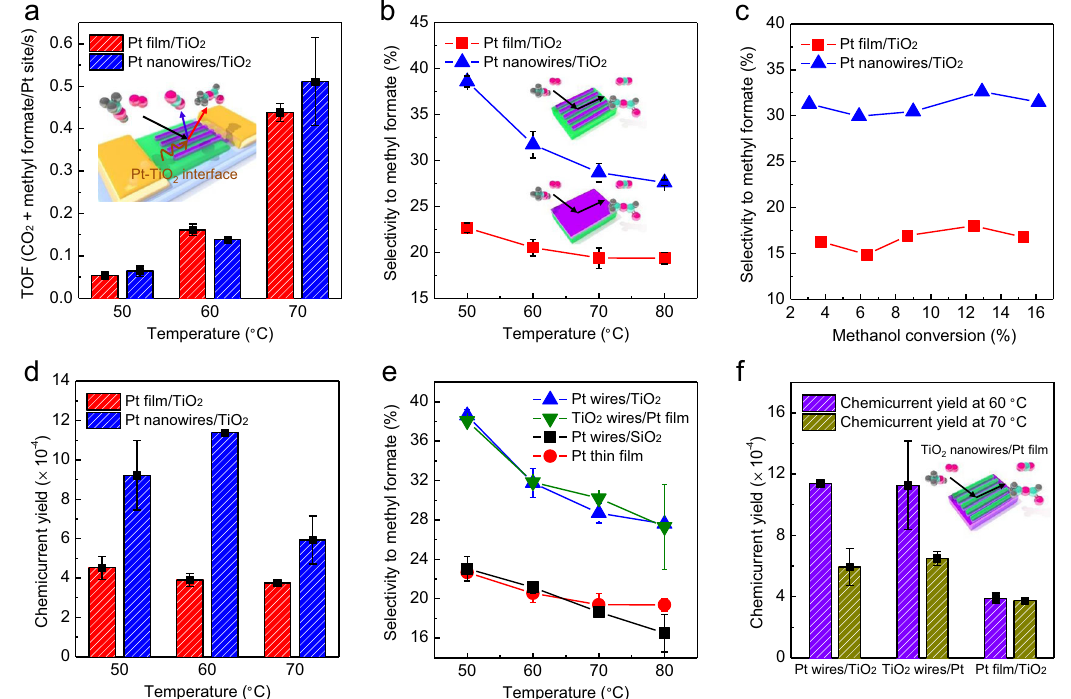
Fig. 2 Selectivity and hot electron generation on nanodiodes. Comparison of a total reactivity and b partial oxidation selectivity under methanol oxidation for two Schottky nanodiodes of Pt fi lm and Pt nanowires supported on TiO 2 at different temperatures. c Plot of selectivity according to methanol conversion on the catalytic nanodiodes of Pt fi lm/TiO 2 and Pt nanowires/TiO 2 measured at 343 K. d Chemicurrent yield associated with the ef fi ciency for hot electron fl ow obtained from the Pt fi lm/TiO 2 and Pt nanowires/TiO 2 catalytic nanodiodes during methanol oxidation reaction. e Selectivity to methyl formate and f chemicurrent yield under methanol oxidation on the Schottky nanodiodes with different oxide support or stack order of nanowires. All results were obtained under methanol 4 Torr and O 2 to 760